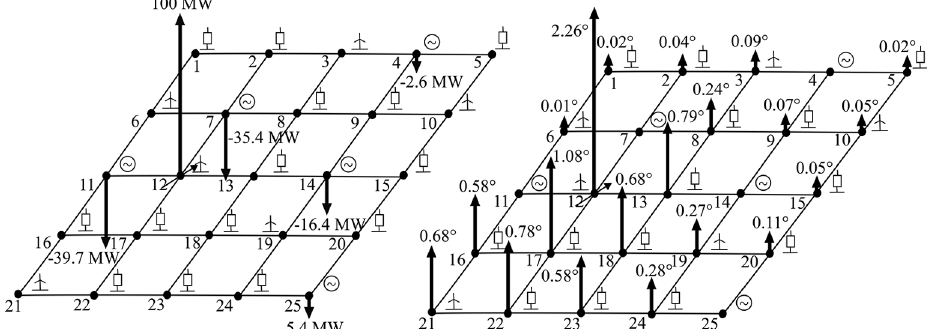
Fig. 15. – Left: increase of power production by PV generator at node 12 and the resulting decreases in the generation of every slack power plant. Right: angle changes in PV generators and PQ consumers during the increase in power generation at node